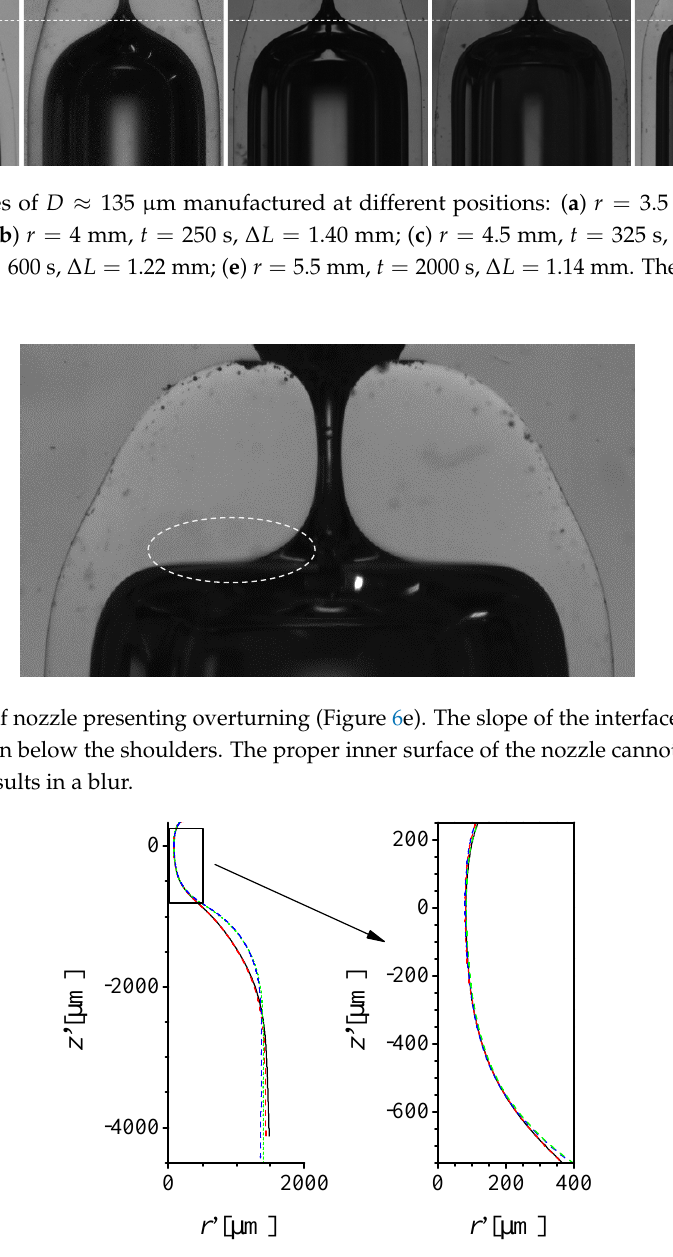
Figure 8. Shape comparison for sets of nozzles with D ≈ 160 µ m produced with different heating conditions from capillaries type 1. The heating conditions were ( r = 3.5 mm, t = 120 s) for the black and the red nozzles, and ( r = 4 mm, t = 180 s) for the blue and the green